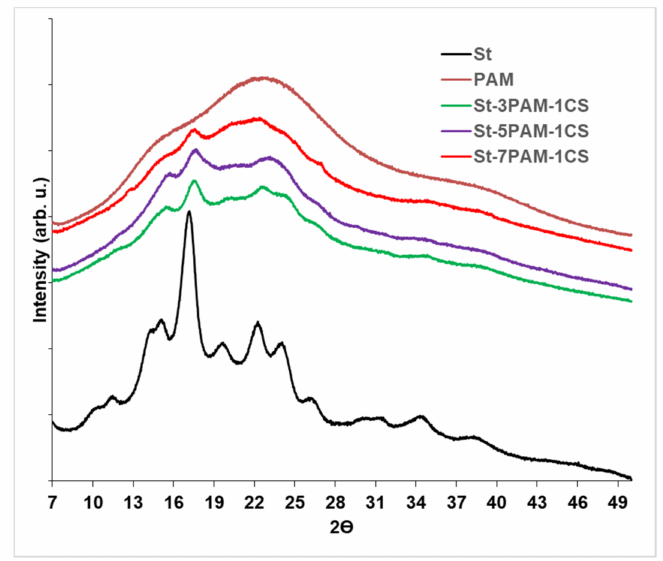
Figure 3. Wide angle X-ray powder diffraction spectra for starch (St), polyacrylamide (PAM), and starch grafted polyacrylamide hybrids with 1 wt.% of CSs and the St:AM molar ratio of: 1:3 (St- 3PAM-1CS), 1:5 (St-5PAM-1CS), and 1:7